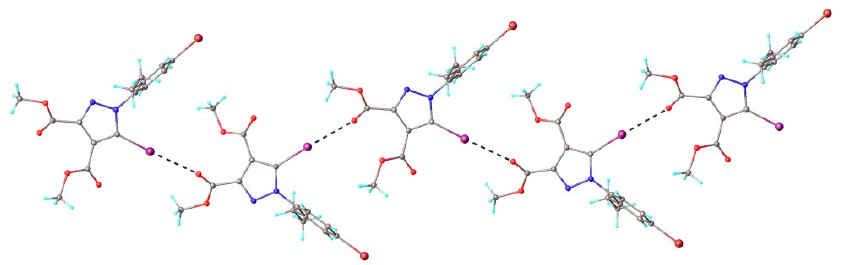
Figure 9. Partial view of the 1D supramolecular chain in the crystal structure of 4 . Halogen bond parameters: C9-I1···O1 [C9-I1 2.056(5) Å, I1···O1(– x , y – 0.5, 1.5 – z ) 2.952(4) Å, ∠ C9I1O1 175.9(2)°].